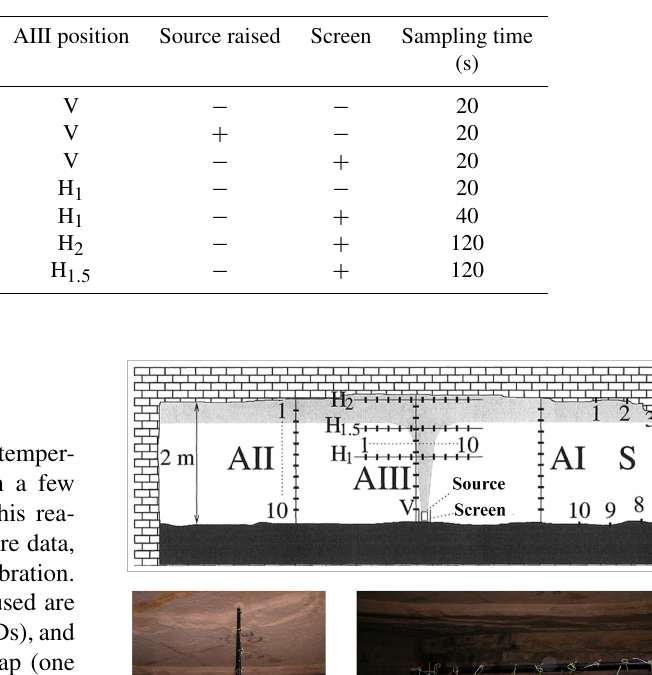
Table 1. Configurations of the experiments carried out in March–June 2003. Each was performed with a heat source of 100W and lasted 24h. AIII position indicates the device orientation: V for vertical and H z for horizontal at altitude z .